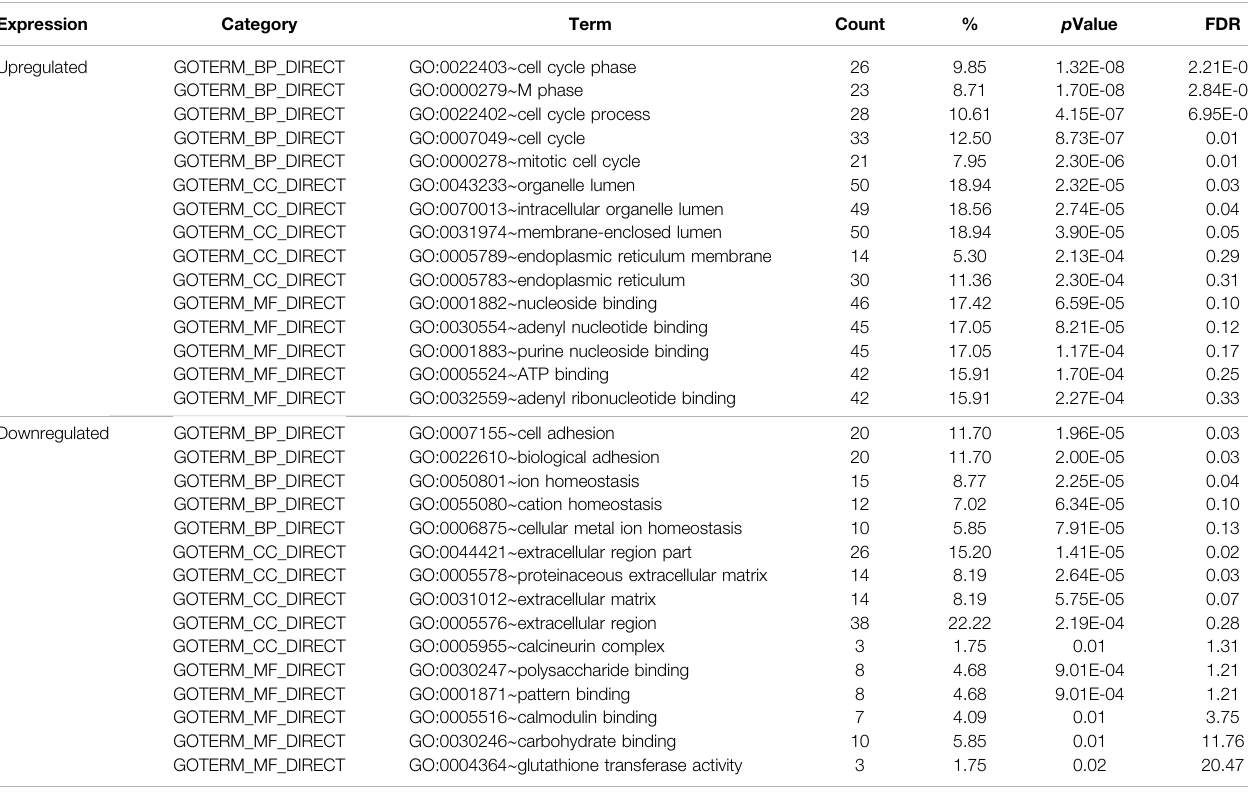
TABLE 2 | Gene ontology analysis of differentially expressed genes associated with Fn-infected Caco-2 cells. Expression Category Upregulated